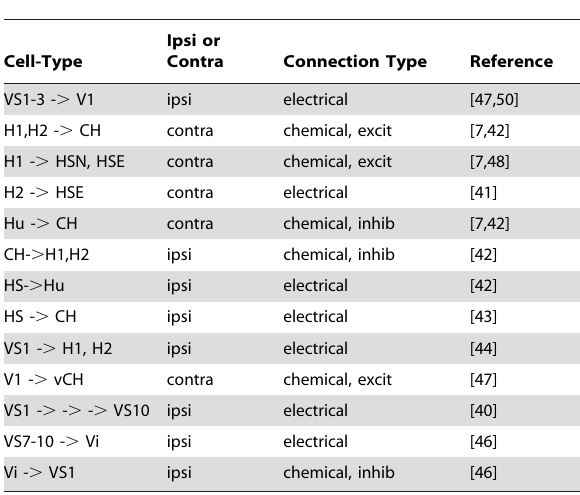
Table 1. Experimental basis of connections implemented in the